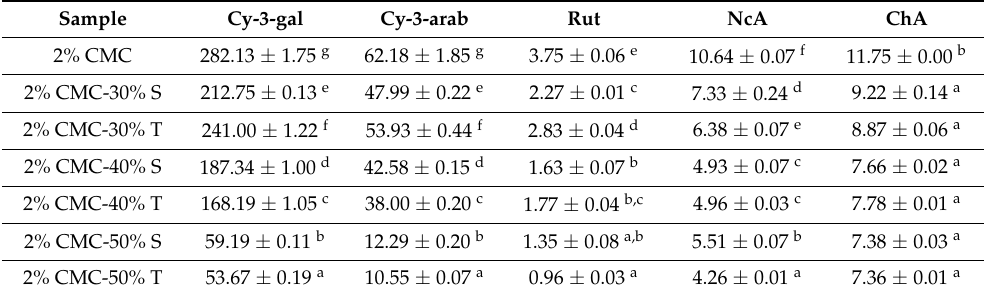
Table 5. Concentrations of individual polyphenols in chokeberry hydrogels and chokeberry juice (mg/kg) determined using HPLC analysis.